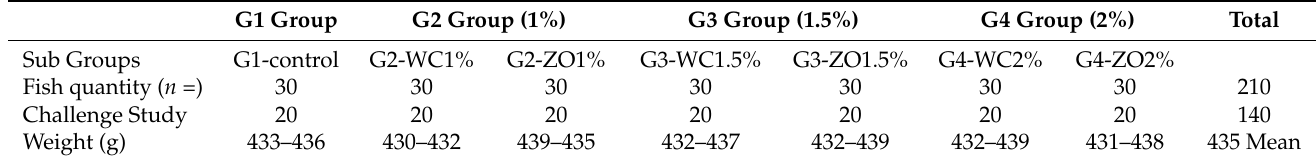
Table 3. Group categorization and feed